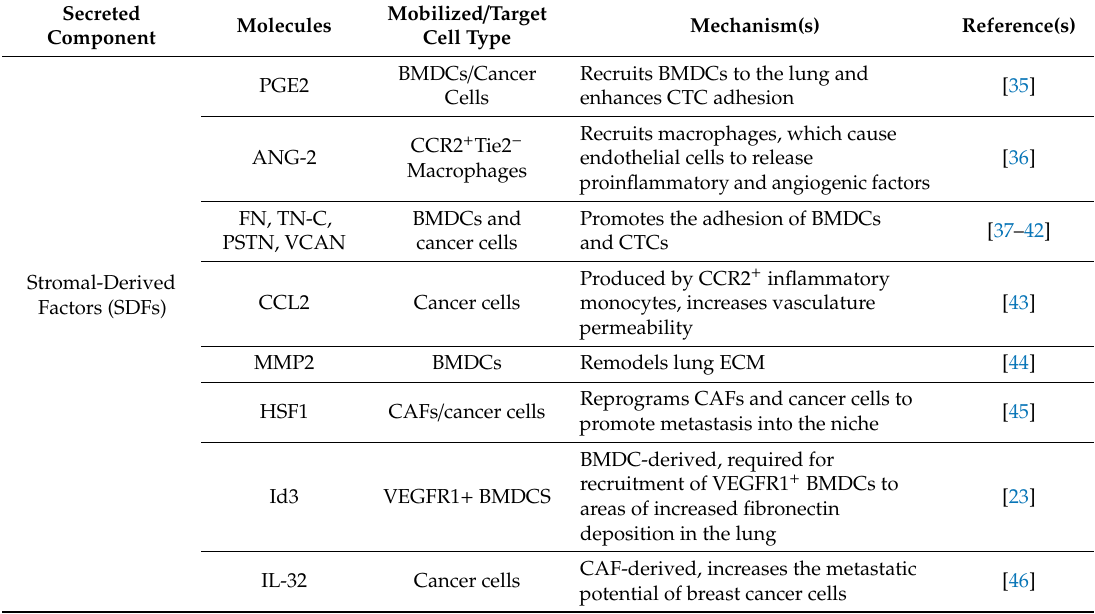
Table 2. Molecular and cellular components secreted by stromal cells associated with promoting breast cancer metastasis to the